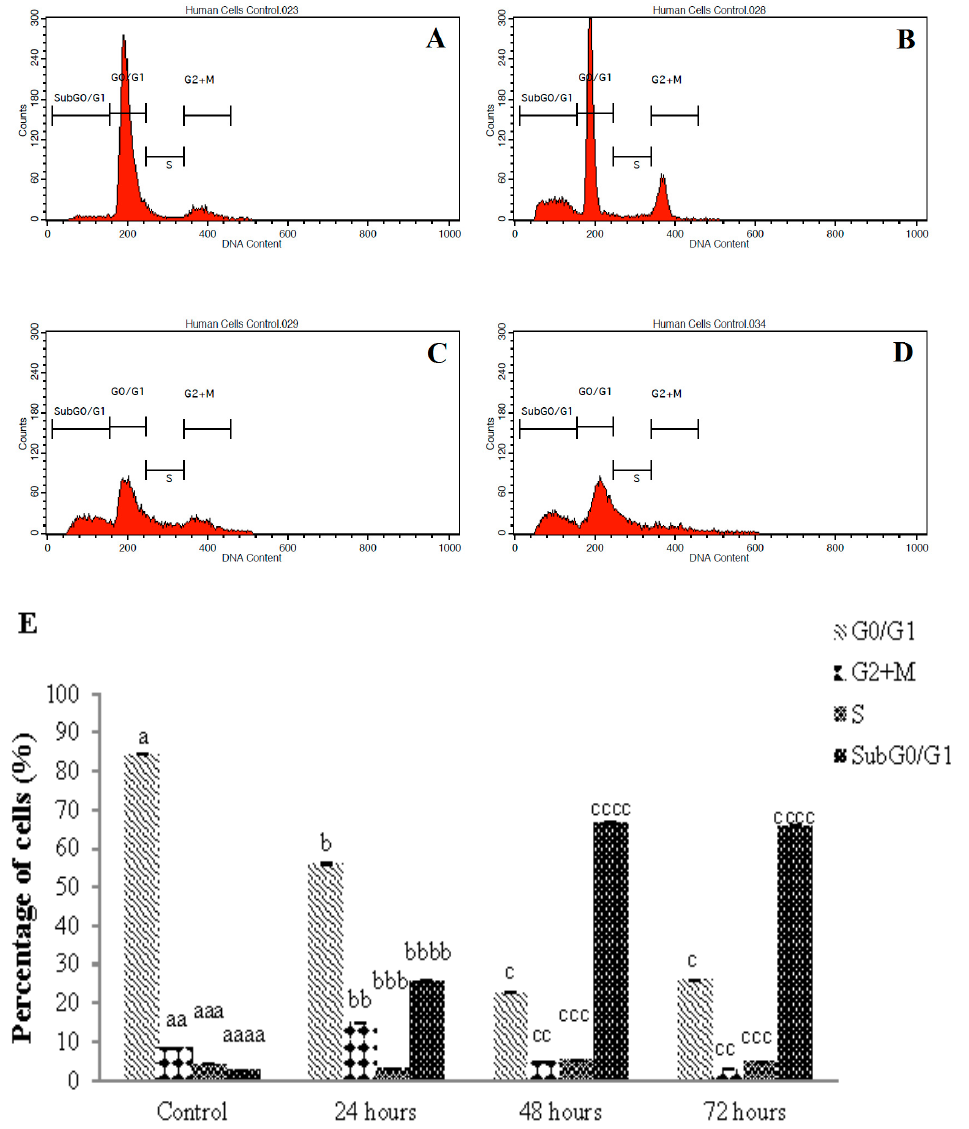
Figure 5. Cell cycle arrest histograms of HepG2 cells treated with sulforaphene (33.8 µ M) in a time-dependent manner, and analysed by flow cytometry. Cells were cultured in serum-free RPMI-1640 medium and maintained at 37 ◦ C and 5% CO 2 . ( A ) Untreated cells after 72 h with highest cell arrest at G 0 /G 1 phase; Cells treated at ( B ) 24 h; ( C ) 48 h; and ( D ) 72 h. Images represent one of three independent experiments. ( E ) Chart comparison of cell cycle arrest phases after sulforaphene treatment in a time-dependent manner. Values are presented as means ± SD of triplicate experiments, and means with different letters differ significantly ( p < 0.05).